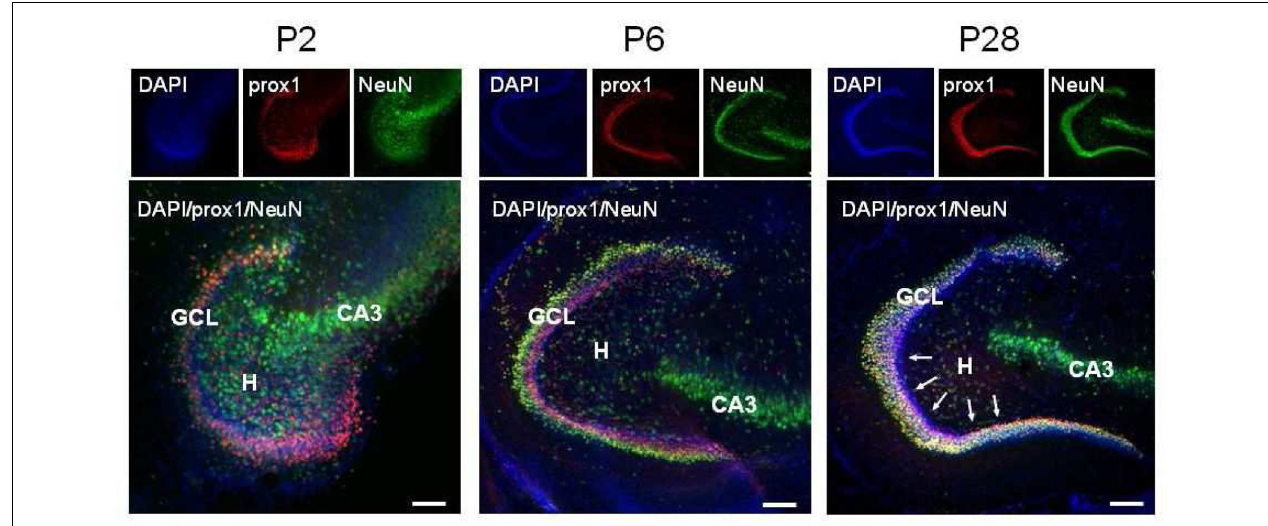
FIGURE 1 | Representative confocal images of immunostained P2, P6, and P28 horizontal sections of the hippocampus. DAPI staining, Prox1 and NeuN immunoreactivity are in blue, red, and green, respectively. Pink (DAPI + , Prox1 + , NeuN − ), immature granule cells predominate in the